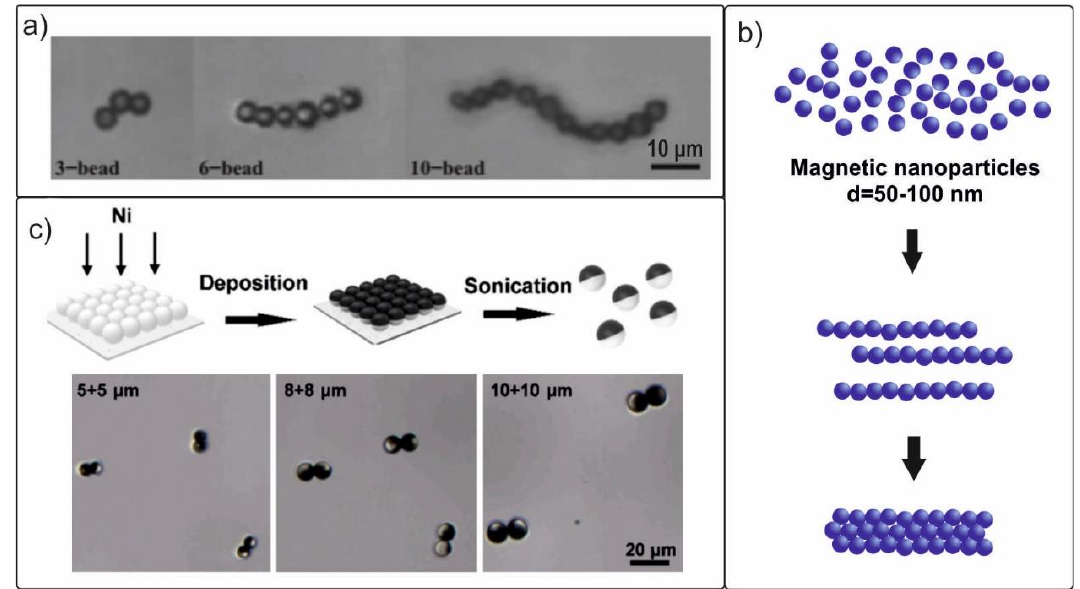
Figure 5. ( a ) Photos of microswimmers of various lengths collected from chains of microparticles in a magnetic field. Reproduced from [83]. CC BY 4.0. ( b ) Three-stage formation of micro- and nanoswimmers based on iron oxide nanoparticles. ( c ) Design and manufacturing steps of magnetic microdimer swimmers and an optical image of Janus microdimers after magnetization. Reproduced from [85]. CC BY 4.0.